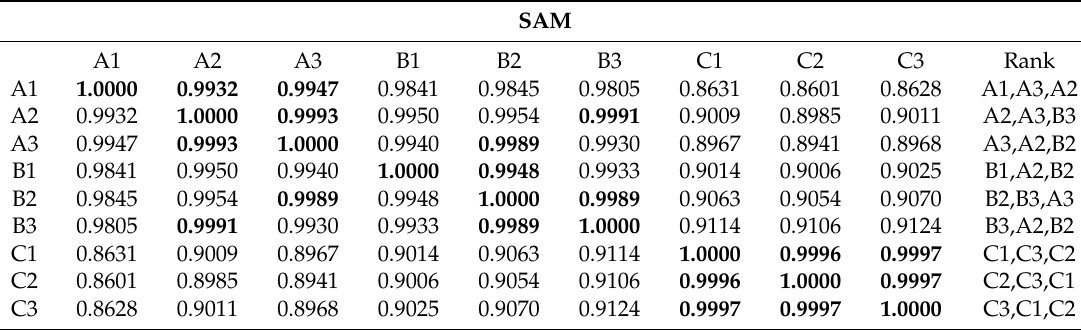
Table 11. The performance of SAM for the ROSIS dataset.